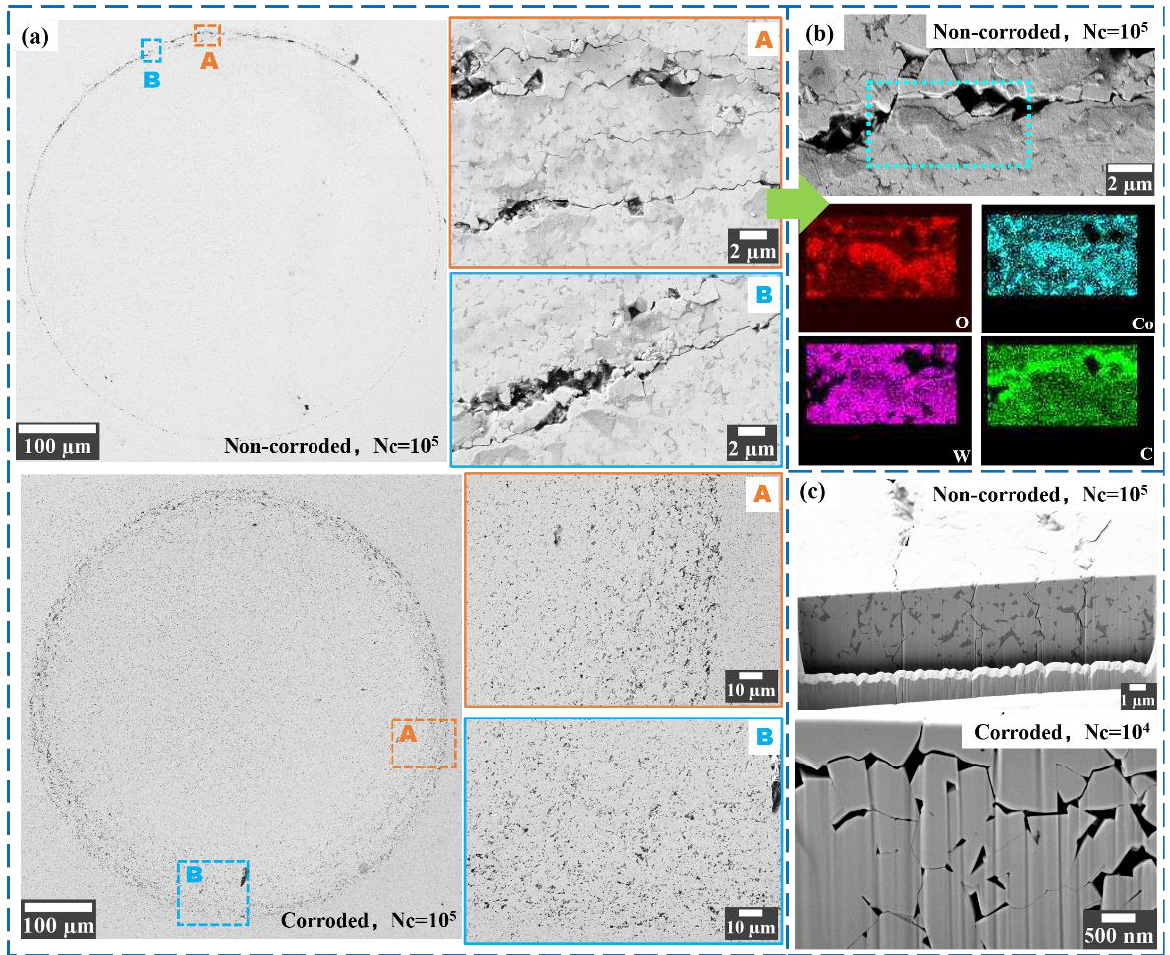
Figure 8. ( a ) FESEM and LSCM images of indented areas (residual imprints) and enlarged views of corresponding square areas under different experimental conditions, ( b ) EDX mapping of residual imprint in an uncorroded hardmetal sample, and ( c ) FIB/FESEM cross-section micrographs of Hertzian contact showing deformation and damage scenarios at the contour of residual impressions (adapted from Ref. [46]).